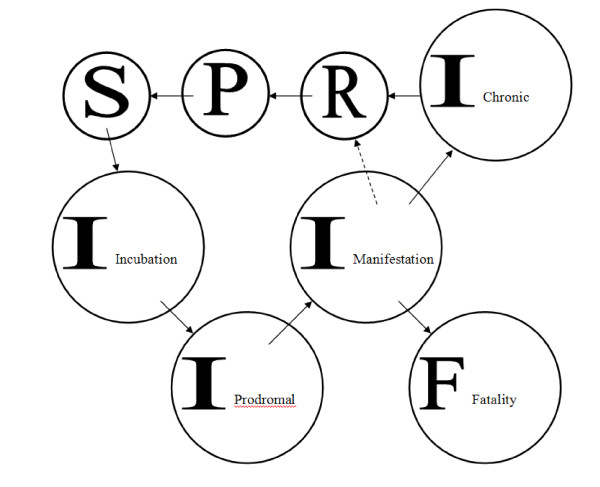
Extended-SIRP disease model of Epiflex. S: susceptible I: Infected R: recovered P: partially immune F: fatality Extended SIRP breaks the infected stage I into 4: IIncubation, IProdromal, IManifestation, IChronic, and adds a fatality terminating stage..